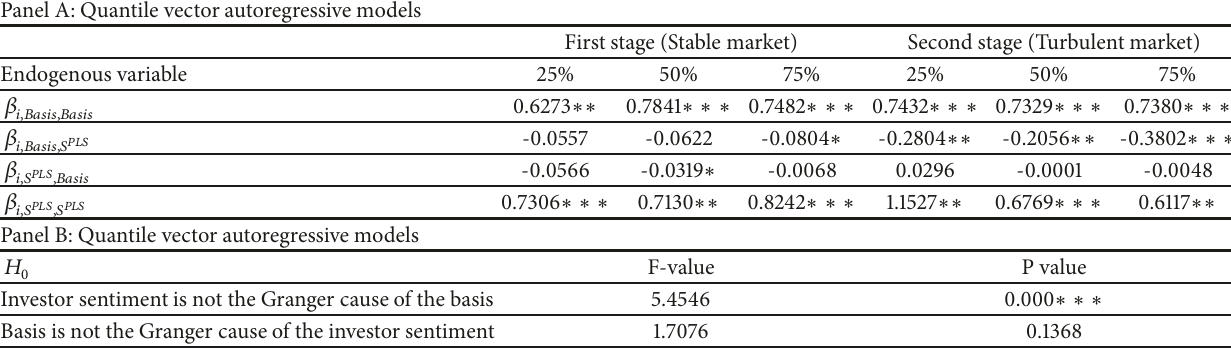
Table 2: Regression results of the quantile vector autoregressive models.